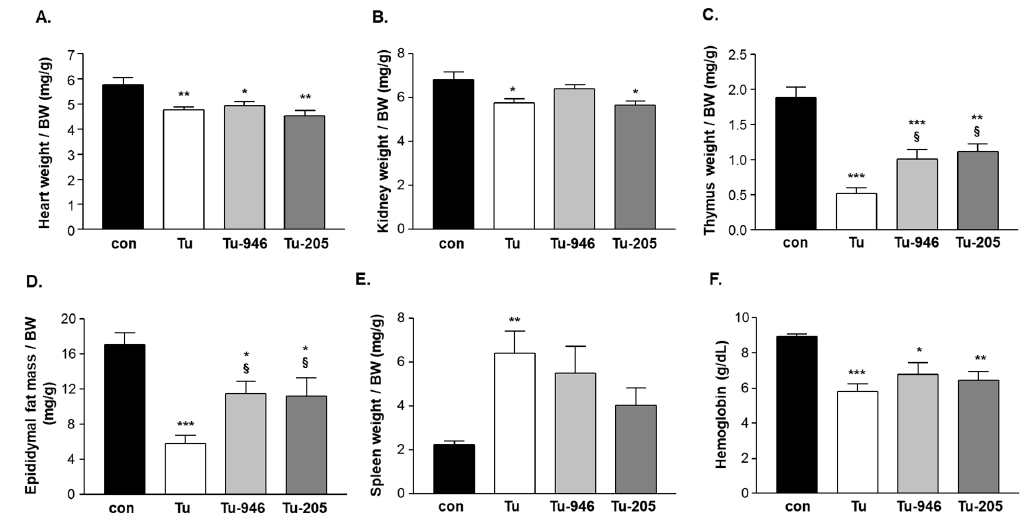
Figure 3. Effects of tumor outgrowth and feeding of Myomed-946 and -205 on heart ( A ), kidney ( B ), thymus ( C ), epididymal fat ( D ), and spleen weight ( E ) by day 24. Tumor outgrowth caused severe loss of epididymal fat, thymus atrophy, and splenomegaly. These effects were significantly offset by Myomed-946 or -205 feeding. Kidney and cardiac atrophy during tumor outgrowth were not significantly prevented by the compounds and remained on Tu levels below con. Clinical chemistry detected severe anemia in Tu mice as apparent by low hemoglobin (Hb) content ( F ). Values are shown as mean ± standard error of the mean, * p < 0.05, ** p < 0.01, *** p < 0.001 vs. con; § p < 0.05 vs. Tu.